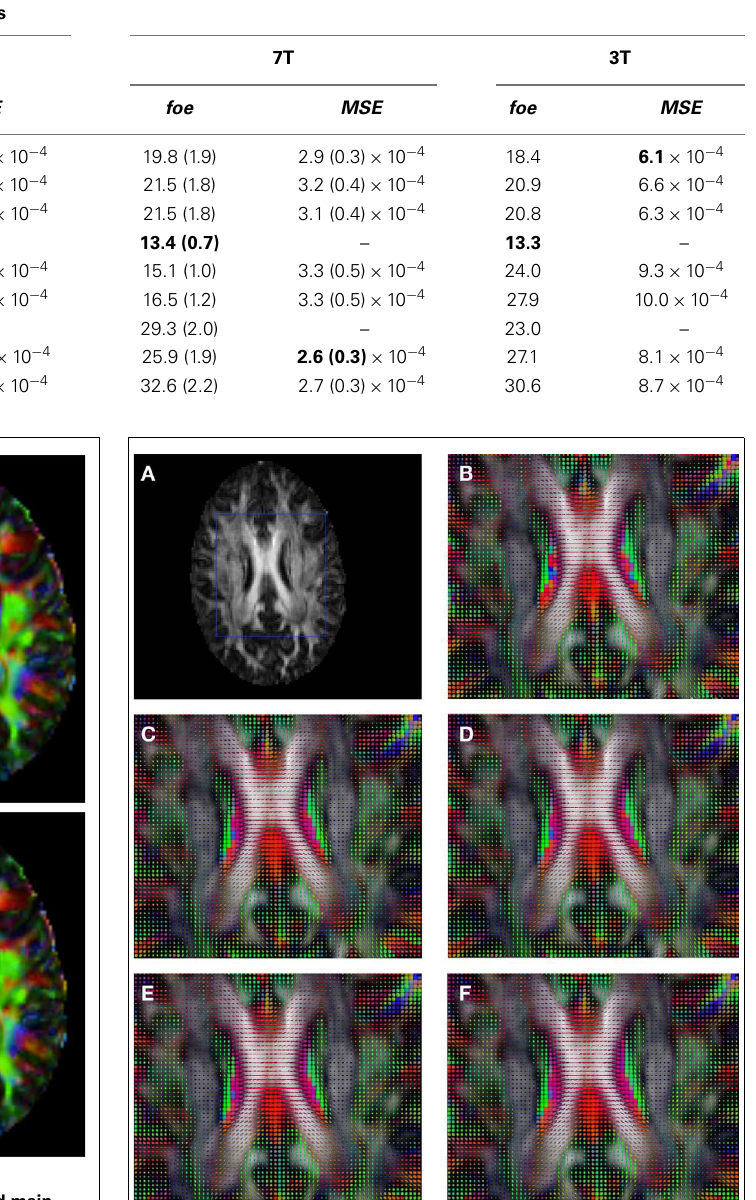
FIGURE 7 | Comparison of the tensors (represented as RGB color coded glyphs) of Subject2 and the tensors of a registered random non-linear transformation of Subject2. (A) Subject2 FA indicating the region selected to show the tensors. (B) Subject2 tensors. Registered tensors using (C) FLIRT-volumes-SH, (D) FLIRT4D-AI, (E) MedINRIA-volumes-SH, and (F)